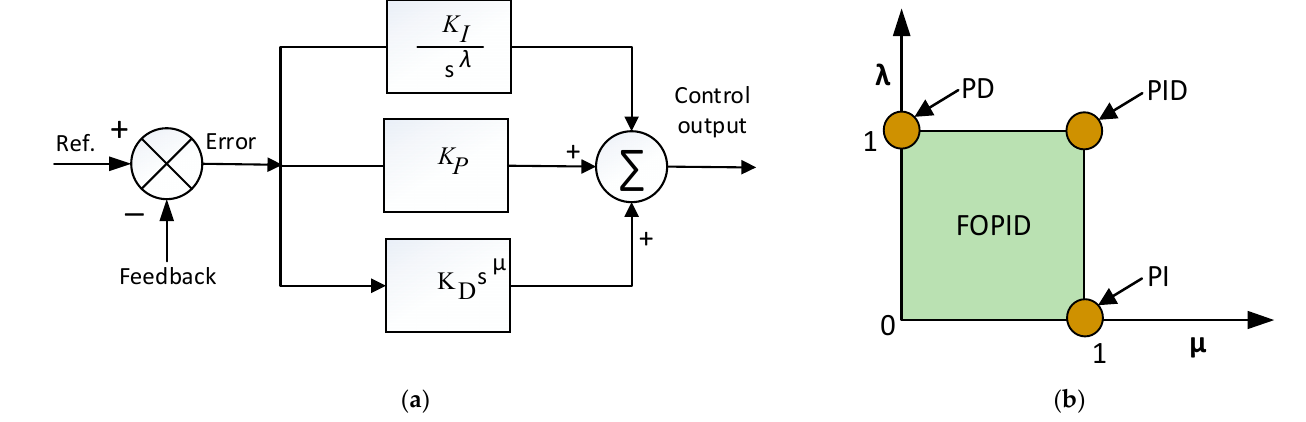
Figure 9. FOPID controller ( a ) Block diagram, ( b ) 𝜇 versus 𝜆 diagram of FOPID.